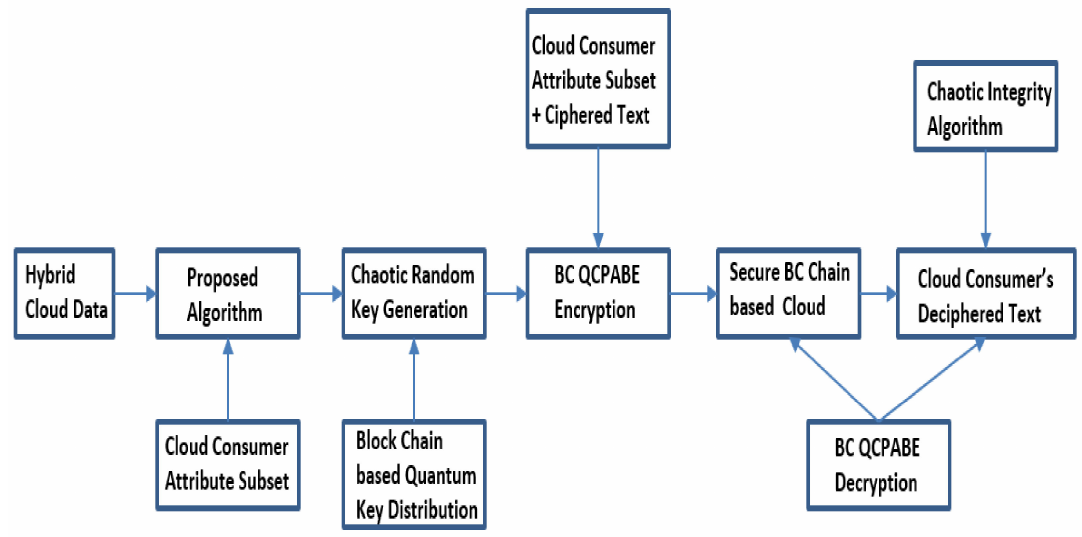
Figure 7. Block Diagram of the Proposed